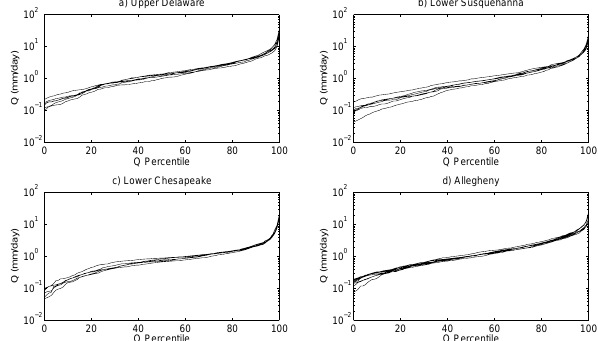
Fig. 3. Flow Duration Curves of all the catchments within (a) Up- per Delaware, (b) Lower Susquehanna, (c) Lower Chesapeake, and (d) Allegheny